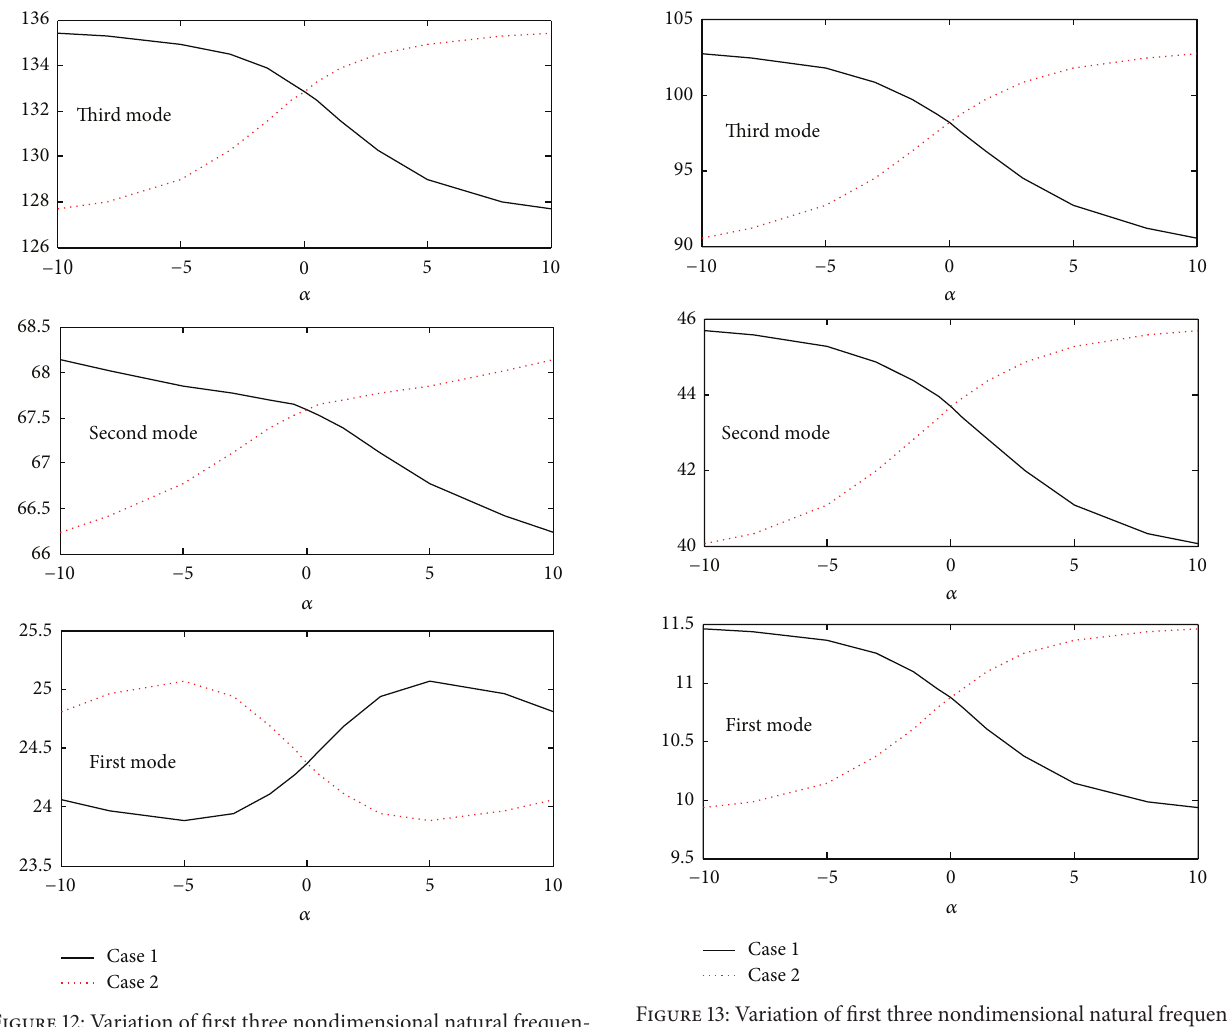
Figure 12: Variation of first three nondimensional natural frequen- cies of an axially FG beam with respect to 𝛼 ; boundary condition: C-C.